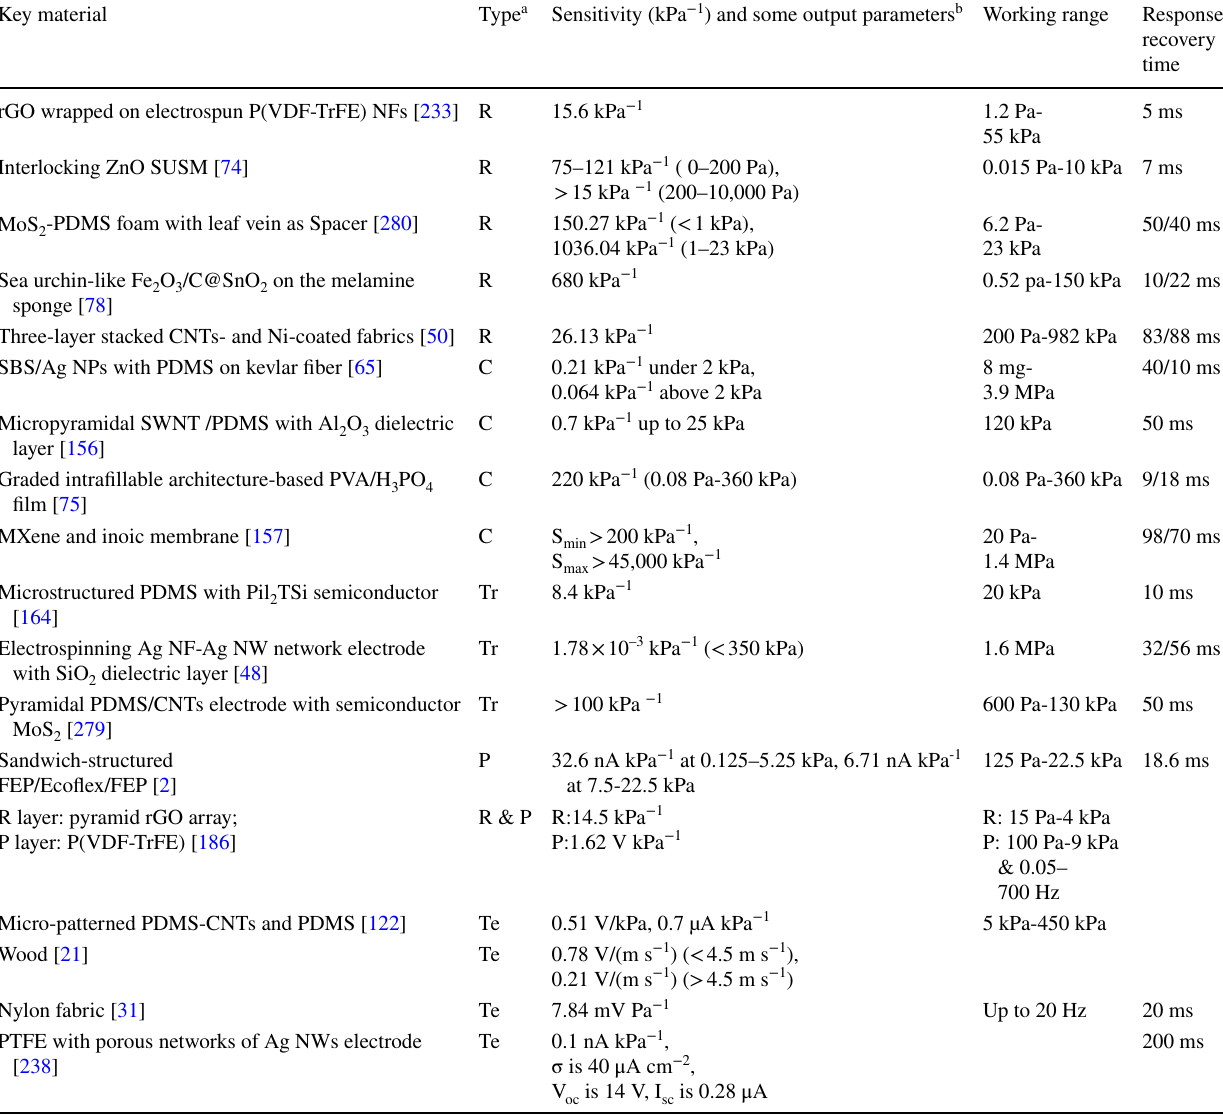
Table 2 Summary of pressure sensors with their performance